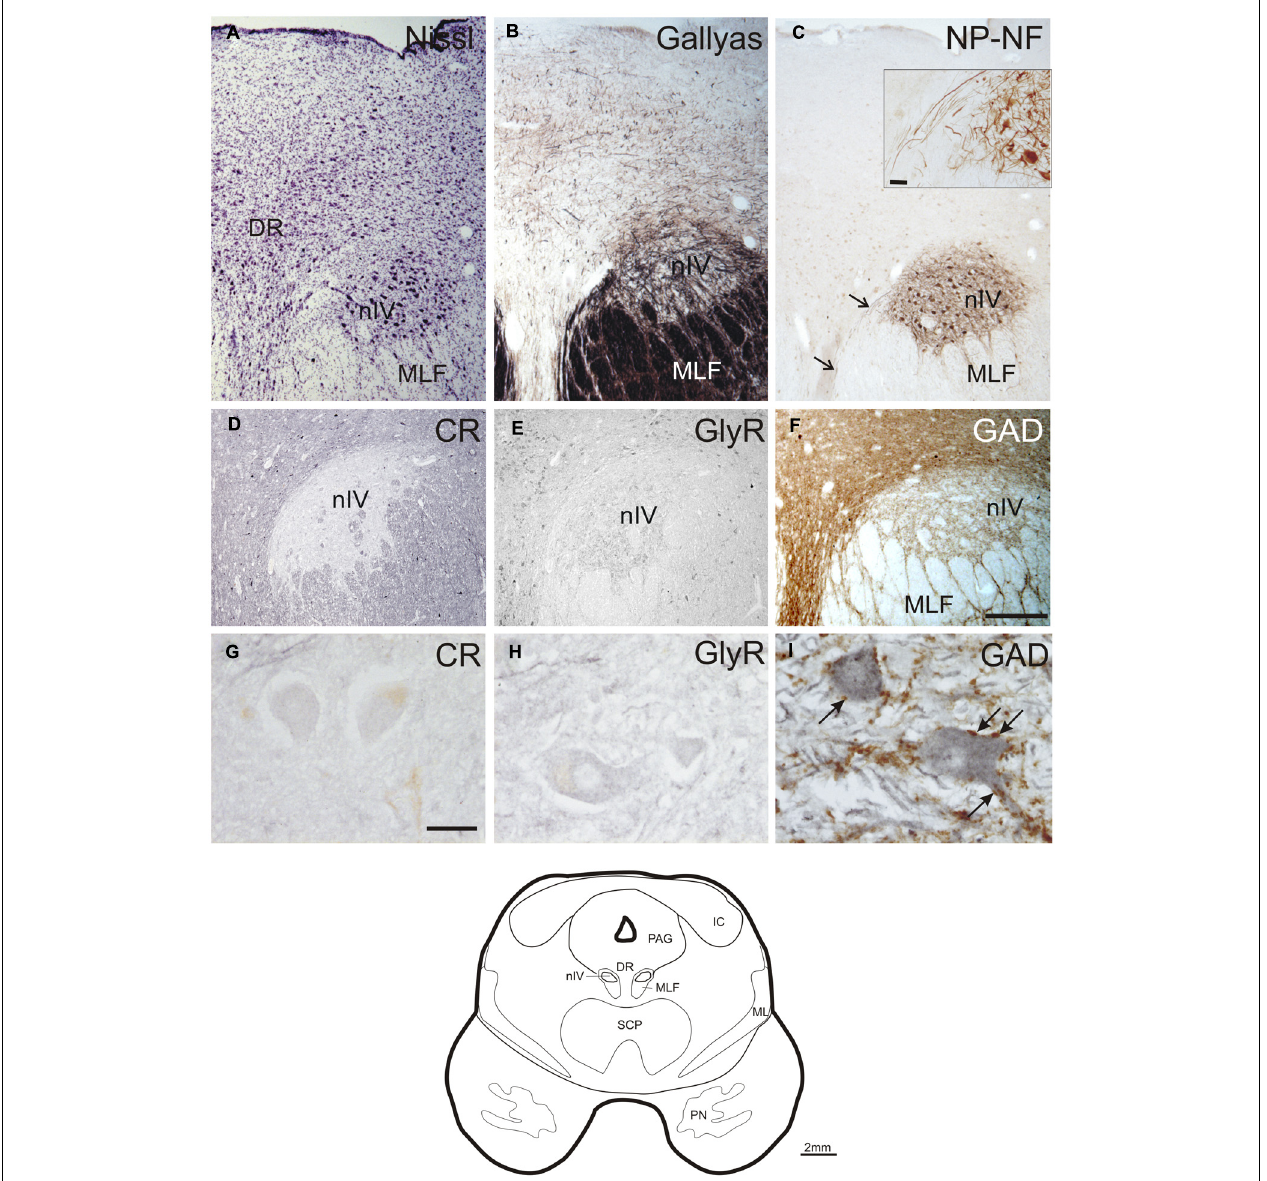
FIGURE 1 |Transverse sections of the human trochlear nucleus (nIV) demonstrating the cytoarchitecture in cresyl violet (A), Gallyas fiber staining (B), and immunostaining for non-phosphorylated neurofilaments (NP-NF) (C). The nIV is devoid of calretinin (CR) expressing neurons and fiber profiles (D,G) ,and it does not express immunoreactivity for the glycine receptor (GlyR) (E,H) .The nIV shows a modest supply by GABAergic punctate profiles revealed with antibodies against glutamate